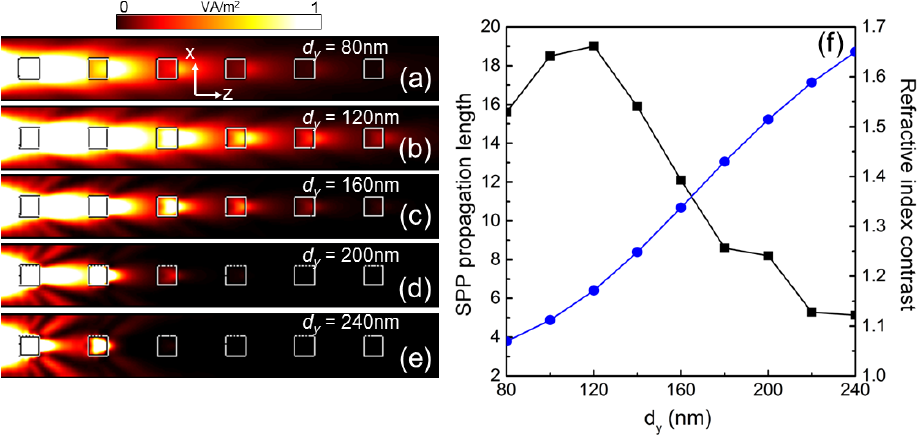
Figure 4. Power distribution on the xz- plane for the case of 3D dielectric cuboids placed periodically with an air gap of p = 2.5 λ 0 and height: ( a ) d y = 80 nm; ( b ) d y = 120 nm; ( c ) d y = 160 nm; ( d ) d y = 200 nm and ( e ) d y = 240 nm. ( f ) Numerical results of SPP propagation distance (black curve) and index contrast (blue curve) as a function of the cuboid height.